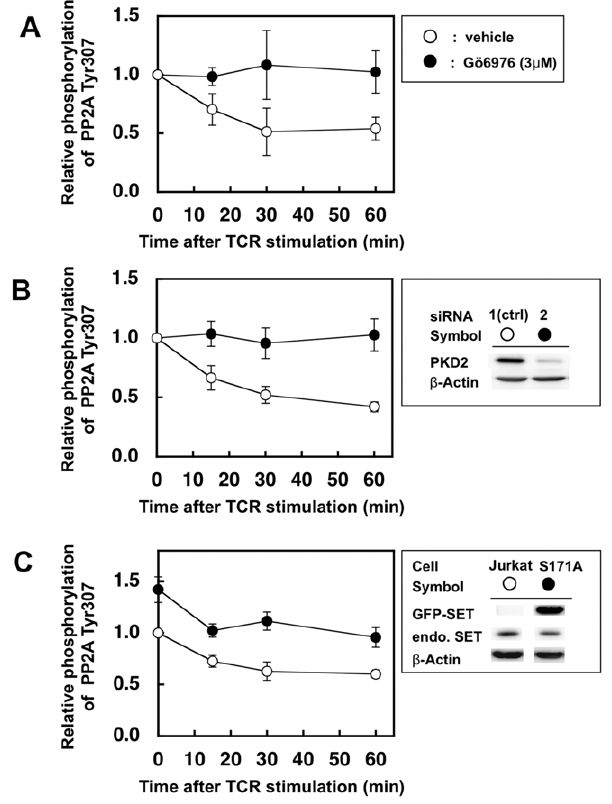
Figure 6. Suppression of PKD2 up-regulates Tyr307 phosphor- ylation of PP2A catalytic subunit after TCR stimulation. (A) Human CD4 + T cell clone was stimulated by L cells expressing its cognate ligands in the presence (closed circles) or absence (open circlse) of PKD2 inhibitor Go¨6976 (3 m M). (B) Jurkat cells treated with siRNA were stimulated by anti-CD3 e antibody and anti-mouse IgG antibody. Treatment with siRNA2 (closed circles) significantly reduced the PKD2 expression, while siRNA1 (open circles) had almost no effect and hence used as negative controls (right panel). (C) Normal Jurkat cells (open circles) and Jurkat cells expressing GFP-SET-S171A (closed circles) were stimulated by anti-CD3 e antibody and anti-mouse IgG antibody. The latter cells expressed 4.5-fold higher GFP-SET-S171A than